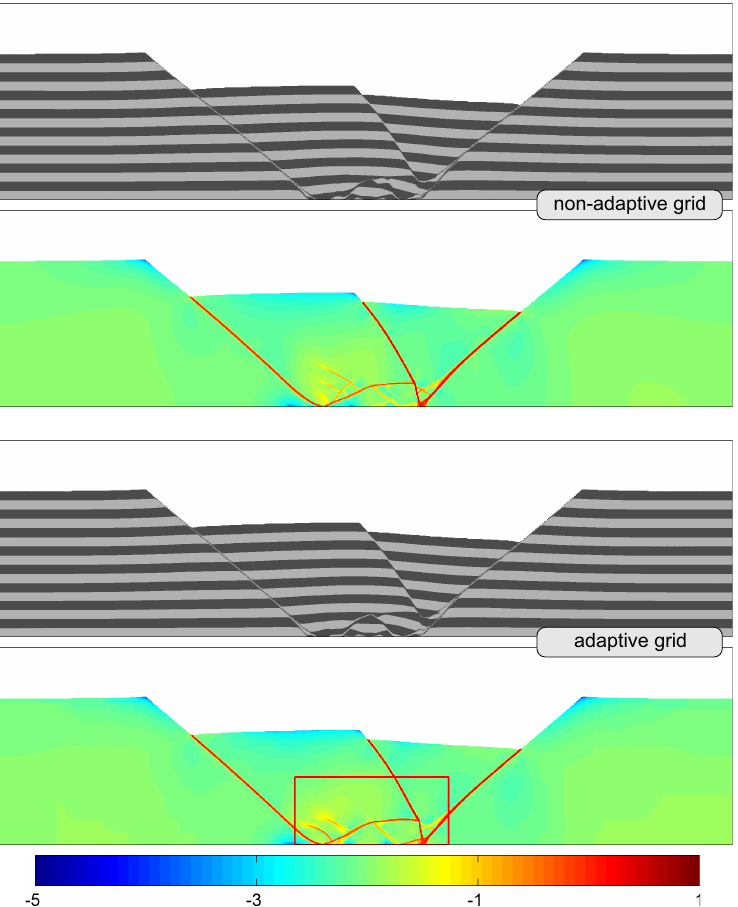
Figure 25. Material fields and log ( ˙ ε II ) plots obtained with non-adaptive and adaptive grids for extension model with φ = 0 ◦ after 25.33% strain. See Figure 26 for zoom as marked by a red rectangle here.